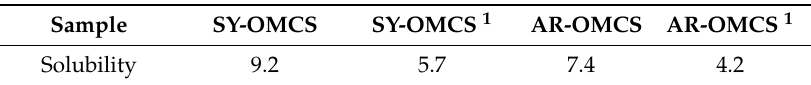
Table 2. Water solubility of polymer dyes.